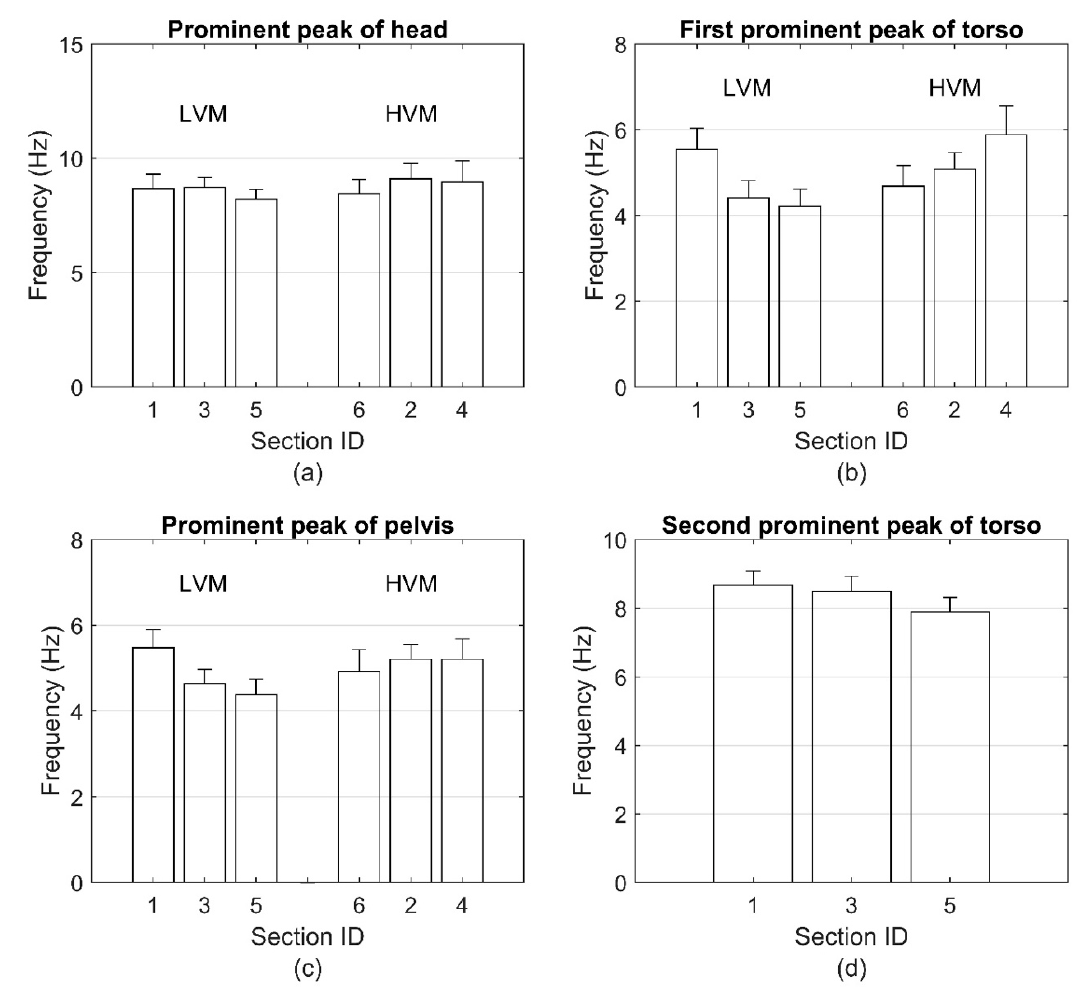
Figure 5. The average prominent peaks of the transmissibilities and their SD under the different LVM and HVM groups at ( a ) the head, ( b ) torso, and ( c , d ) pelvis relative to the vehicle floor for all subjects for Sections 1–6.